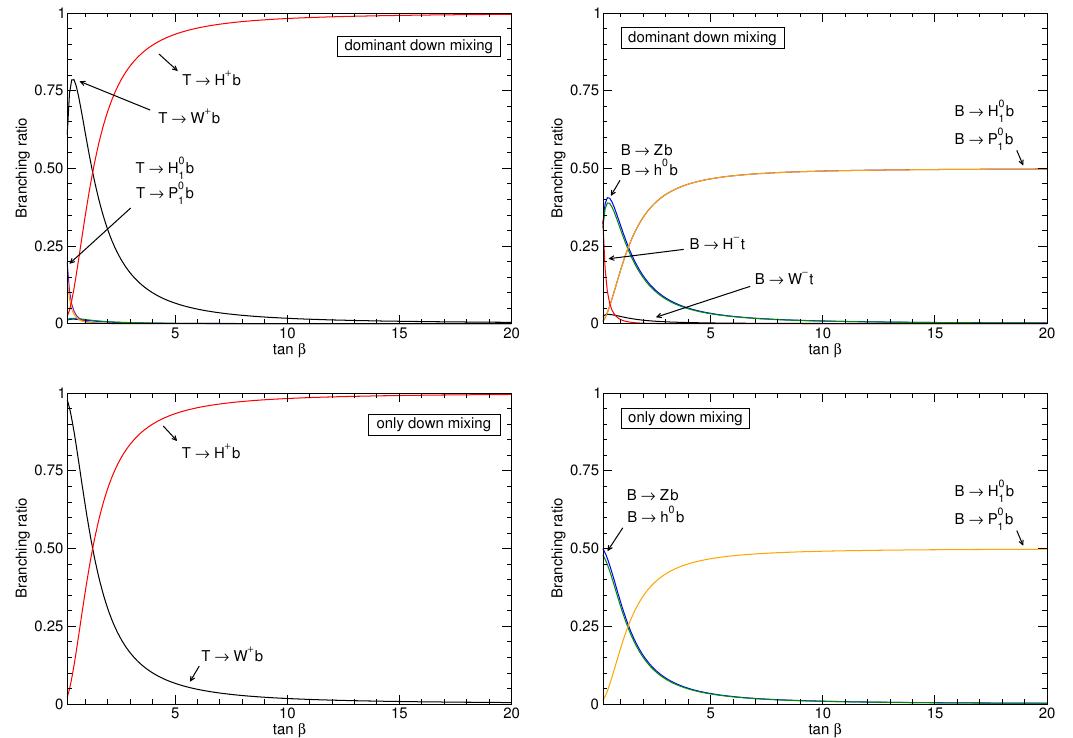
Figure 2 . Dependence of the T and B branching ratios on tan (cid:12) , for the dominant down mixing scenarios of table